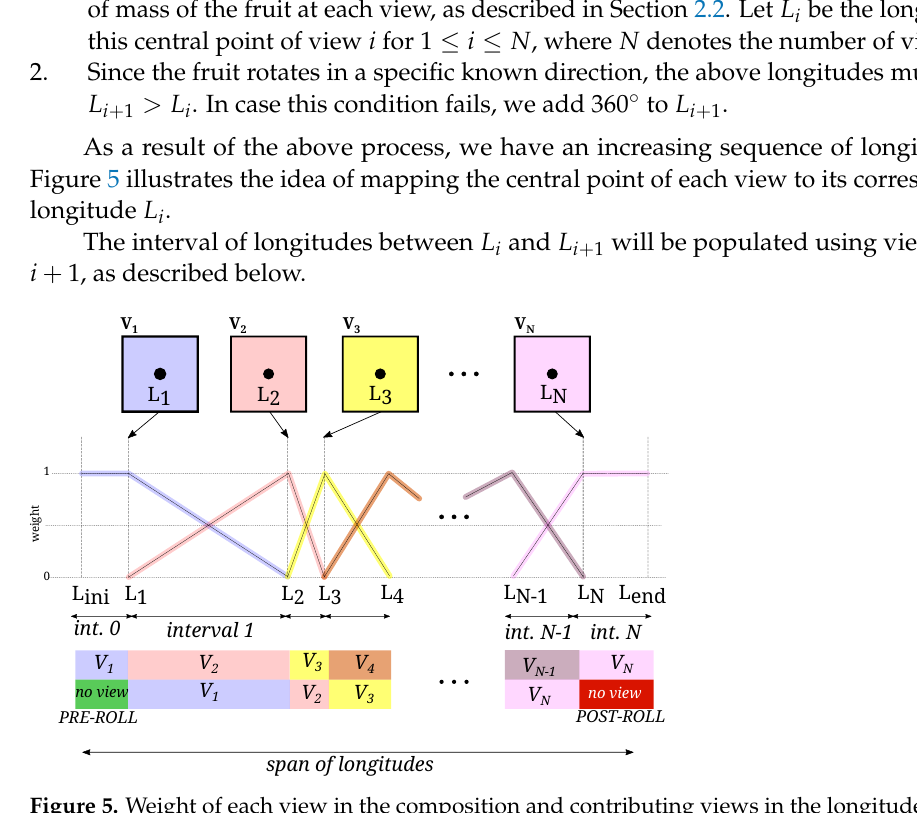
Figure 5. Weight of each view in the composition and contributing views in the longitude range of interest. Notice the extra intervals added before the central longitude of the first view (pre-roll) and after the central longitude of the last view (post-roll). Only one view will be used to draw the map in these